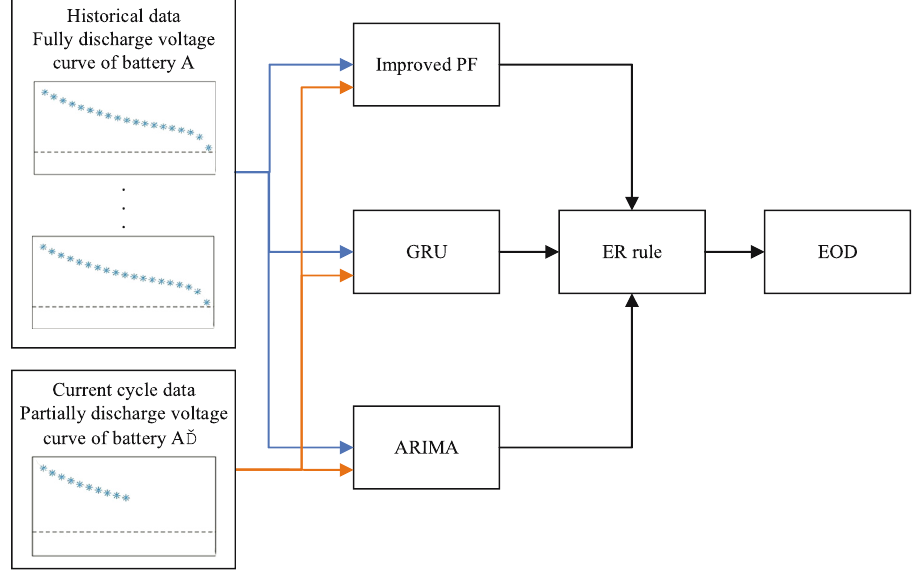
Figure 4: Framework of the proposed